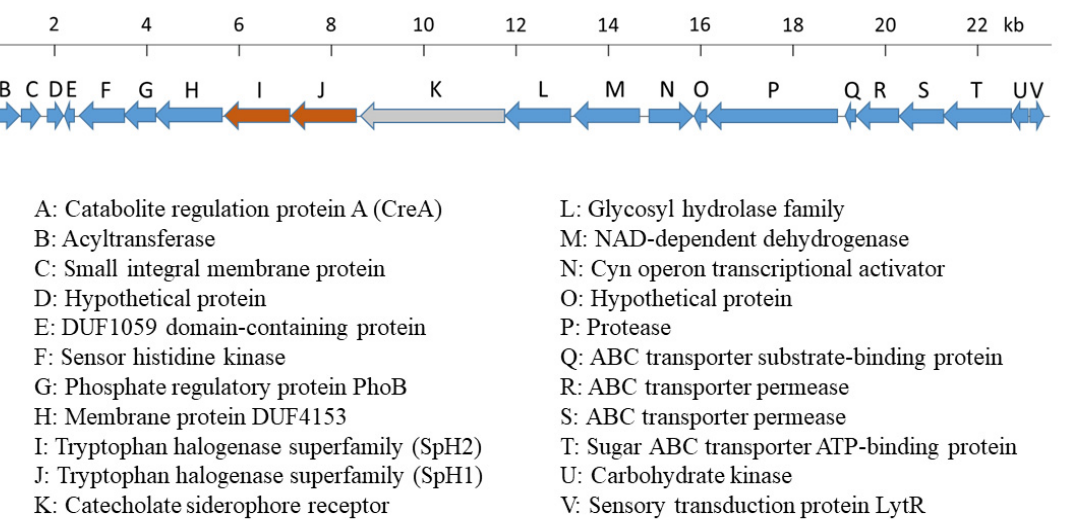
Figure 1. Phylogenetic tree of the hits from the Botryococcus braunii consortia, as well as known Trp halogenases, phenol halogenases, and pyrrol halogenases. The optimal tree, with the sum of branch lengths = 17.80254621, is shown. The newly identified hits all cluster with the flavin-dependent halogenase BrvH. We decided to further analyse hit 21 (SpH1) and hit 20 (SpH2).